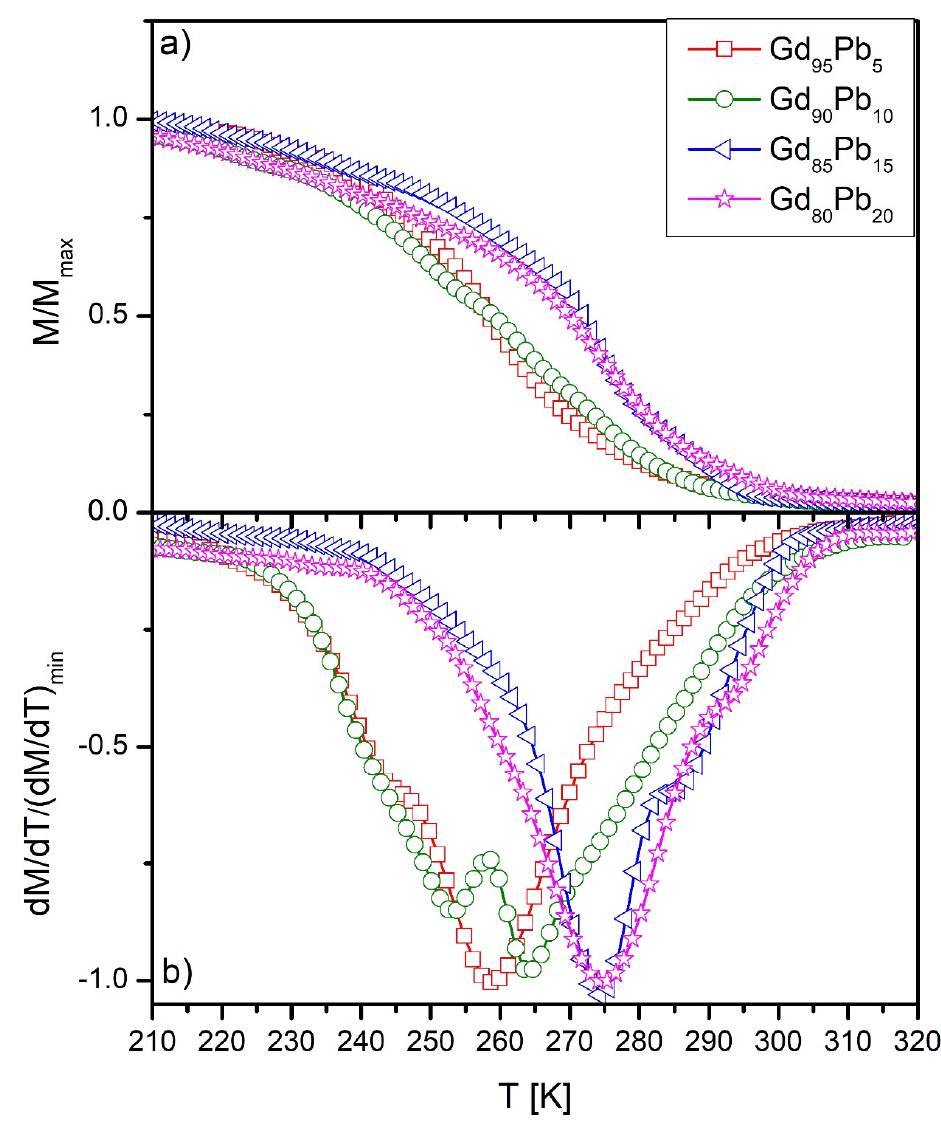
Figure 4. M vs. T curves ( a ) and corresponding dM/dT dependences for all studied samples ( b ). Table 3. The Curie temperature values of recognized phases in the studied alloys.